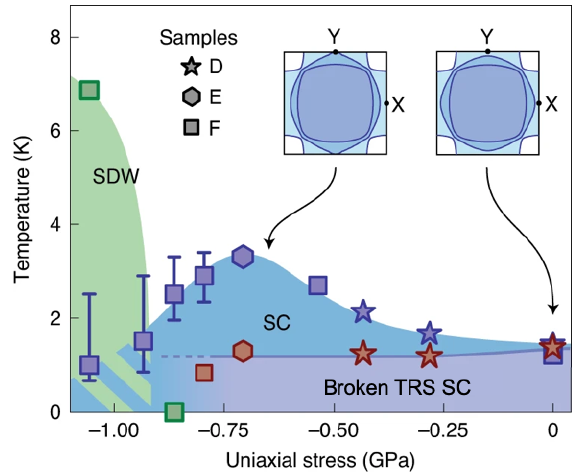
Figure 4. Temperature vs. stress phase diagram of SRO214. The candidates for even-parity supercon- ducting order parameters that break TRS are d + id , s + id and d + ig . The insets illustrate the Fermi surfaces of SRO214 at zero stress and stress where the maximum increase in the T c is observed. Here, SDW stands for spin density wave. (Adopted with permission from [47] copyright NPG 2021).